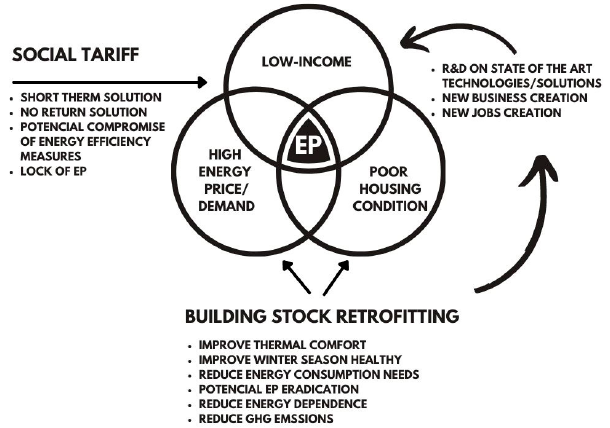
Figure 16. Contributing factors addressing EP and their